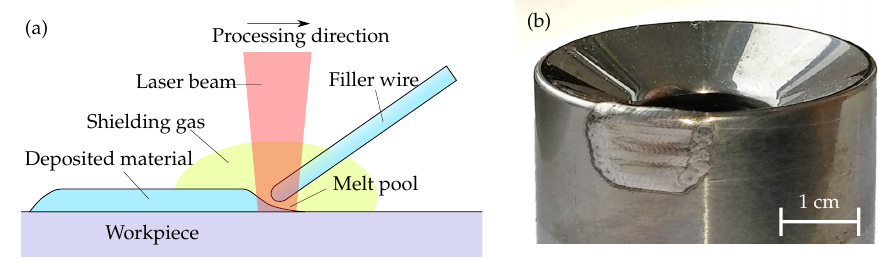
Figure 1. ( a ) Principle of manual laser deposition welding. ( b ) Repaired tool before machining.